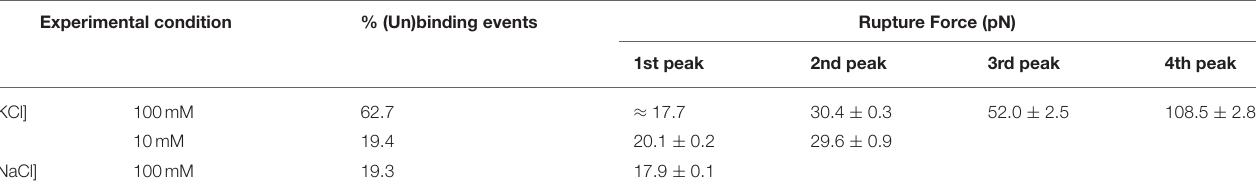
TABLE 2 | Rupture forces and percentage of (un)binding events obtained by AFM-based force spectroscopy for the interaction between WNV C and LDs. Experimental condition